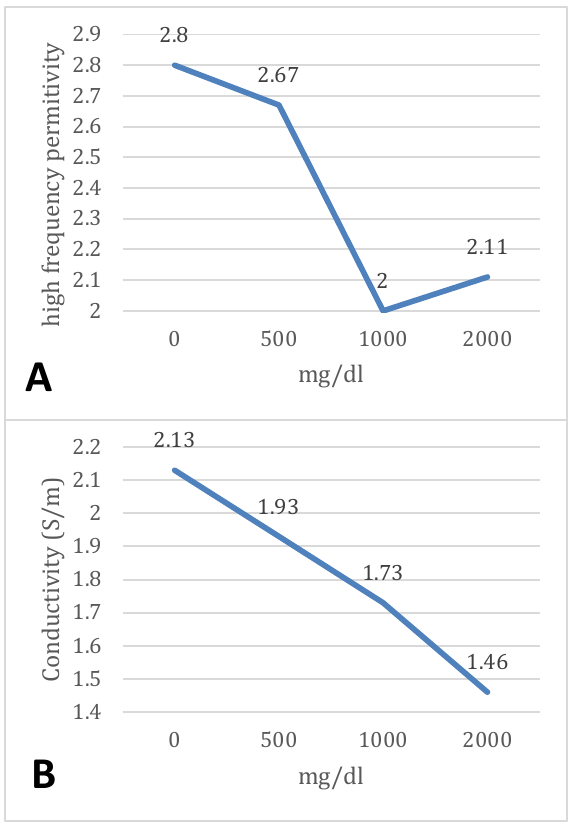
Fig. 8: The dielectric properties of blood vs glucose levels within 0.5 – 20 GHz. A) the permittivity, and B) the conductivity. [17]